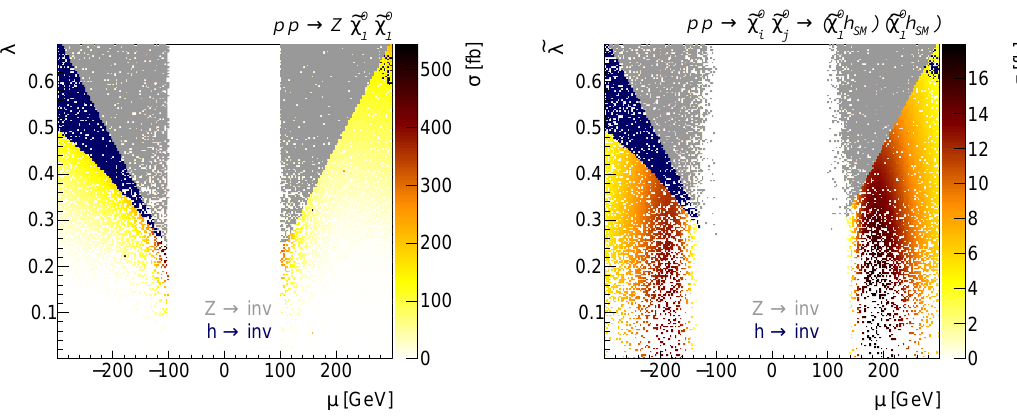
Figure 17: Cross section profiles for the mono- Z (left) and mono-Higgs-pair (right) processes in the µ − λ plane. All points fulfill the chargino mass bounds. Regions excluded by invisible Z and Higgs decays are shown in light gray and dark